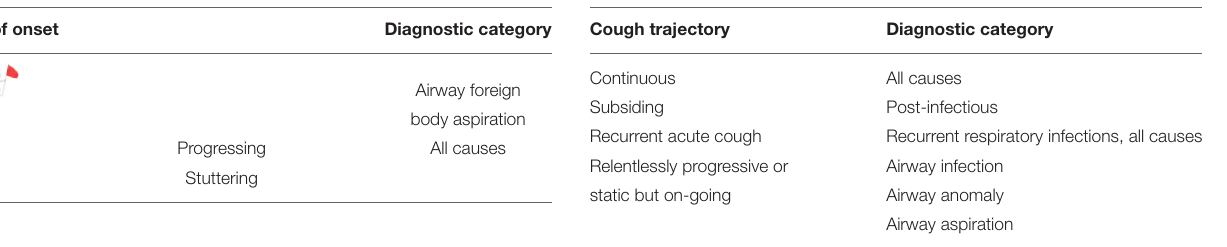
TABLE 3 | Mode of onset and potential diagnostic category. TABLE 4 | Cough trajectory and potential diagnostic